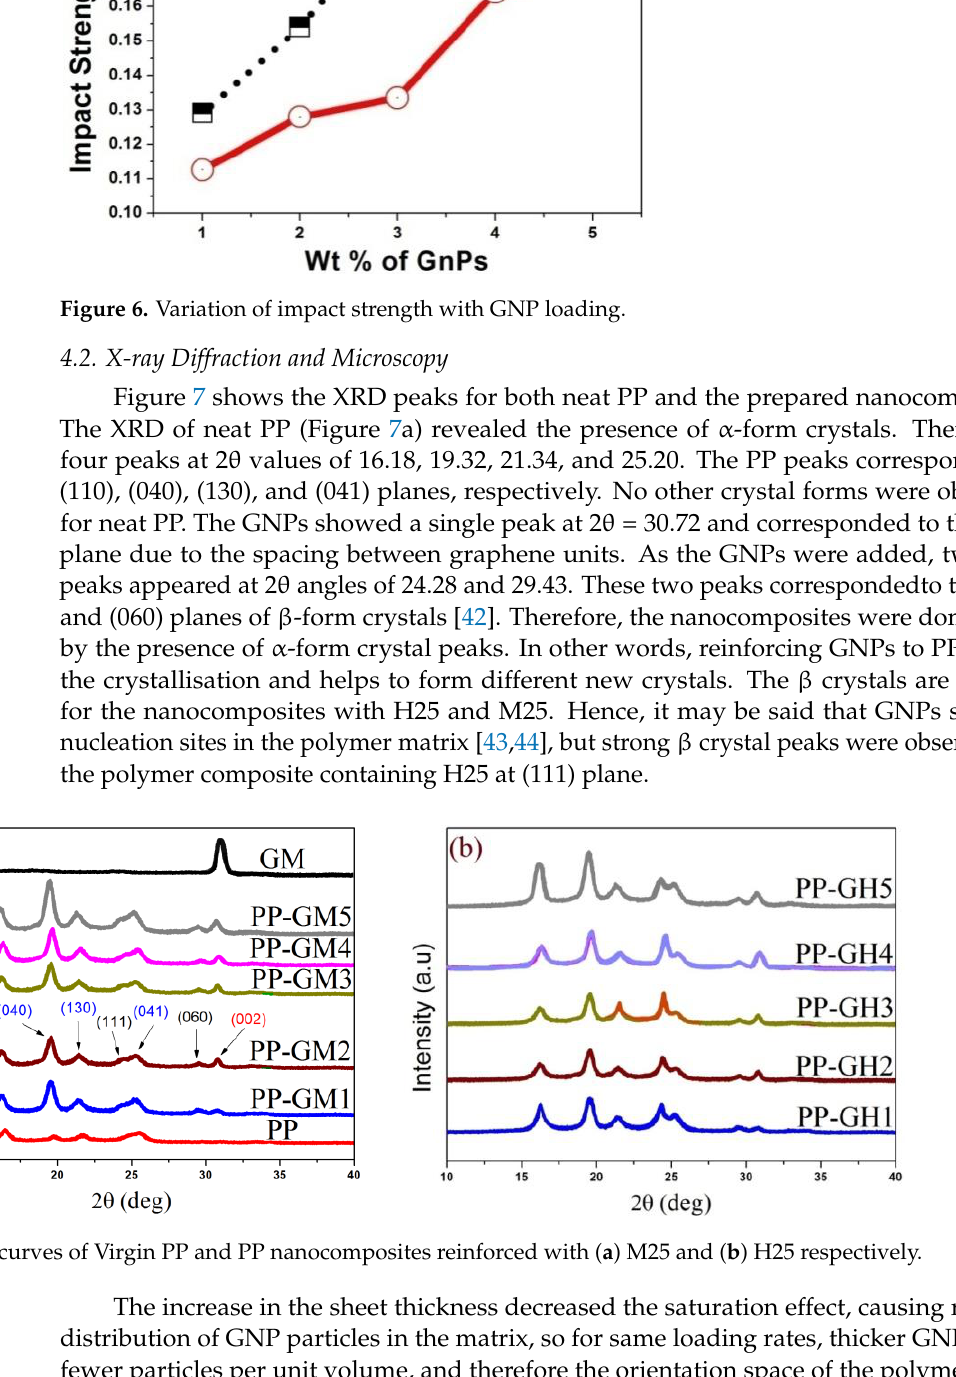
Figure 7. XRD curves of Virgin PP and PP nanocomposites reinforced with ( a ) M25 and ( b ) H25 respectively.